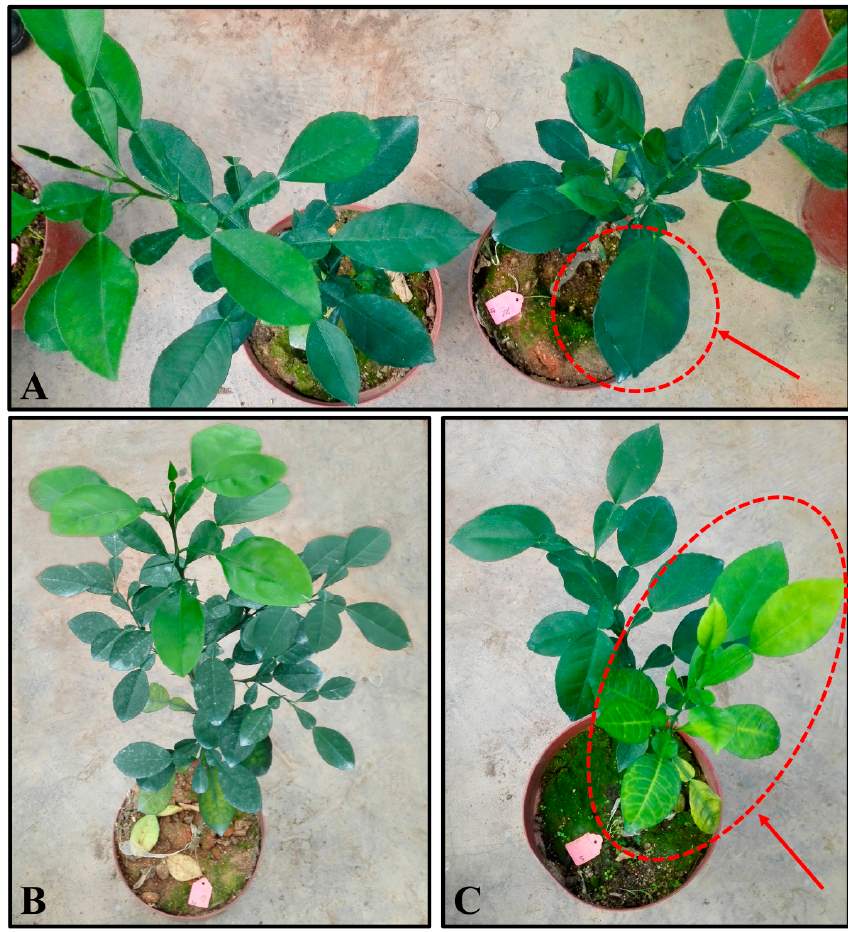
Figure 6. HLB-resistance evaluation of transgenic and non-transgenic control pomelo trees. ( A ): C Las-infected non-transgenic tree (left) and RIN4 -overexpression transgenic RIN4-O5 tree (right) at 2 months post inoculation (mpi). The red arrow indicates the typical HLB mottle leaf symptom. ( B ): C Las-free RIN4 -overexpression transgenic plant; ( C ): C Las-infected RIN4-O2 plant showed vein yellowing symptom at 10 mpi.